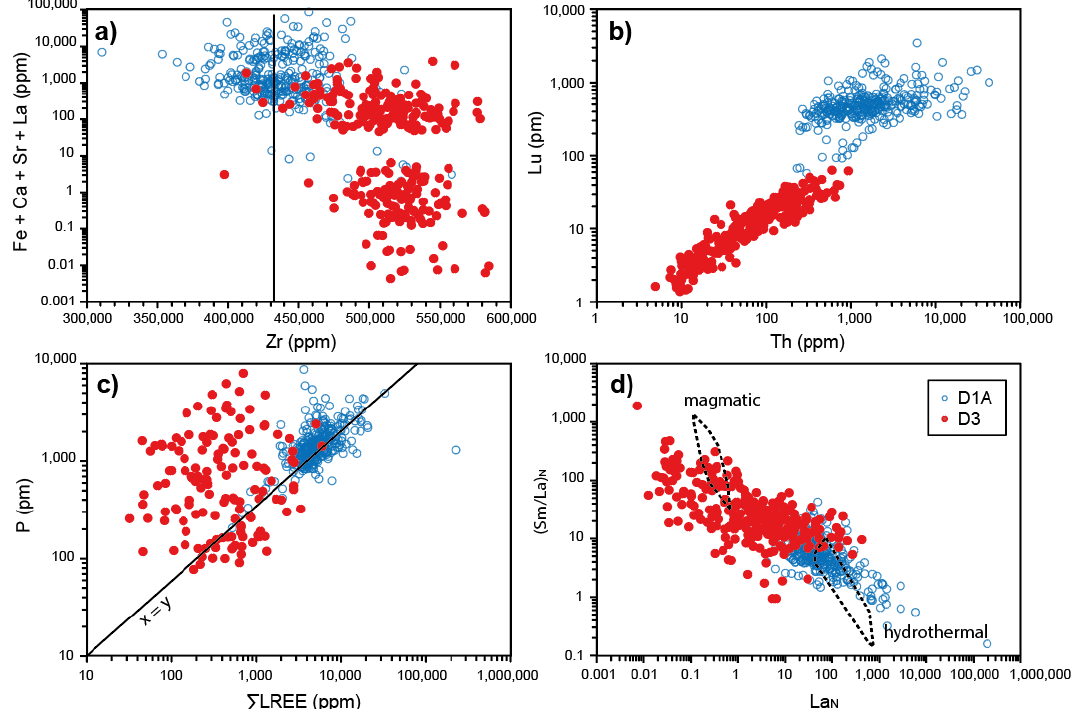
Figure 9. Chemical composition of the studied zircon grains displayed on the binary diagrams ( a ) Zr vs. Fe + Ca + Sr + La, ( b ) Th vs. Lu, ( c ) sum LREE vs. P, and ( d ) La N vs. (Sm/La) N . On the latter diagram, from Hoskin [52], values are normalized to chondrite. Table 3. General chemical composition of zircon grains (median values).